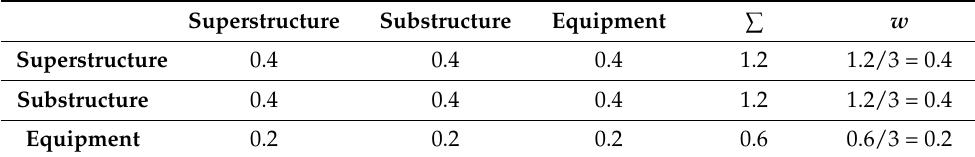
Table 15. Normalization of matrix and final weights of